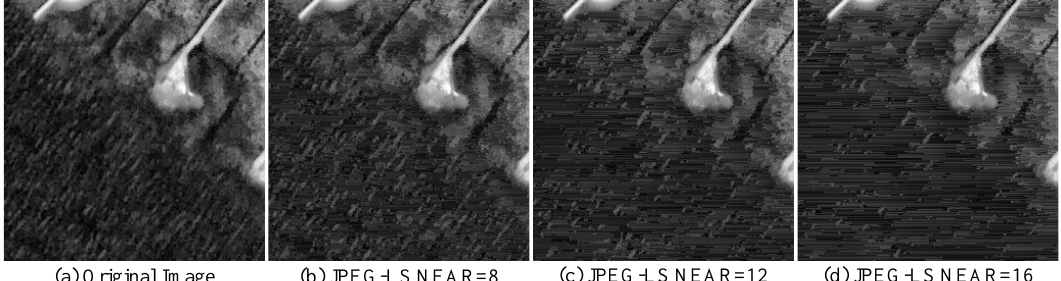
Figure 1. The artifact of JPEG-LS compressed remote sensing images. A large NEAR value corre- sponds to a high compression rate, which results in more serious banding artifacts. To show image details well, we present the compression results in a 16-bit gray-scale format and use local adaptive histogram equalization to enhance its